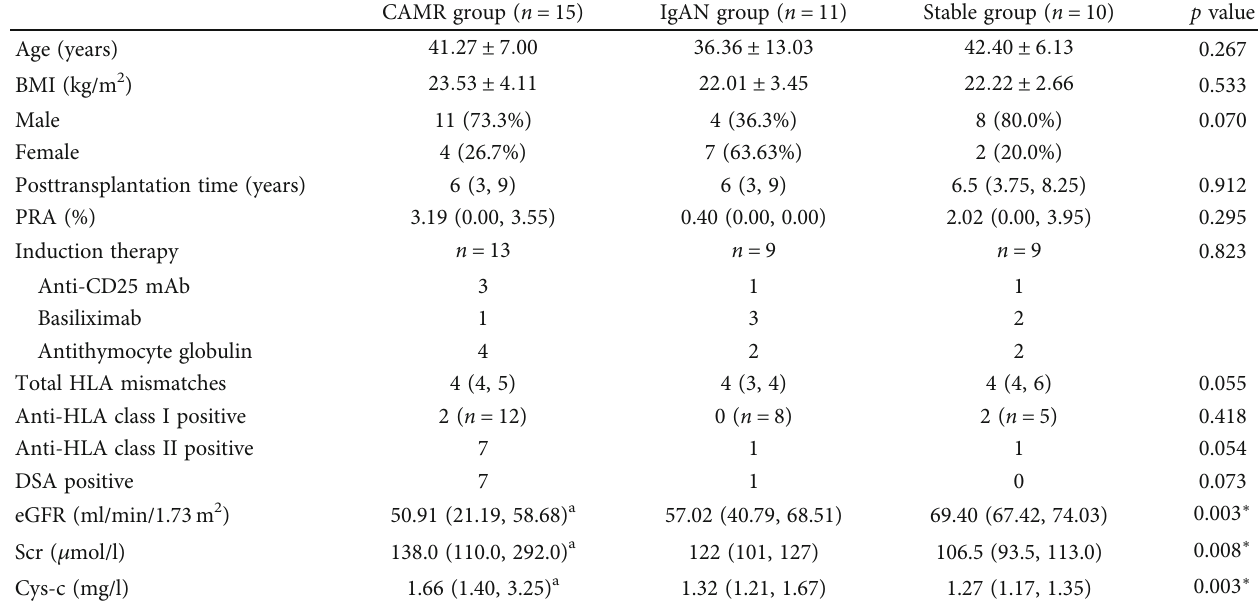
Table 1: Demographic and clinical characteristics of the study